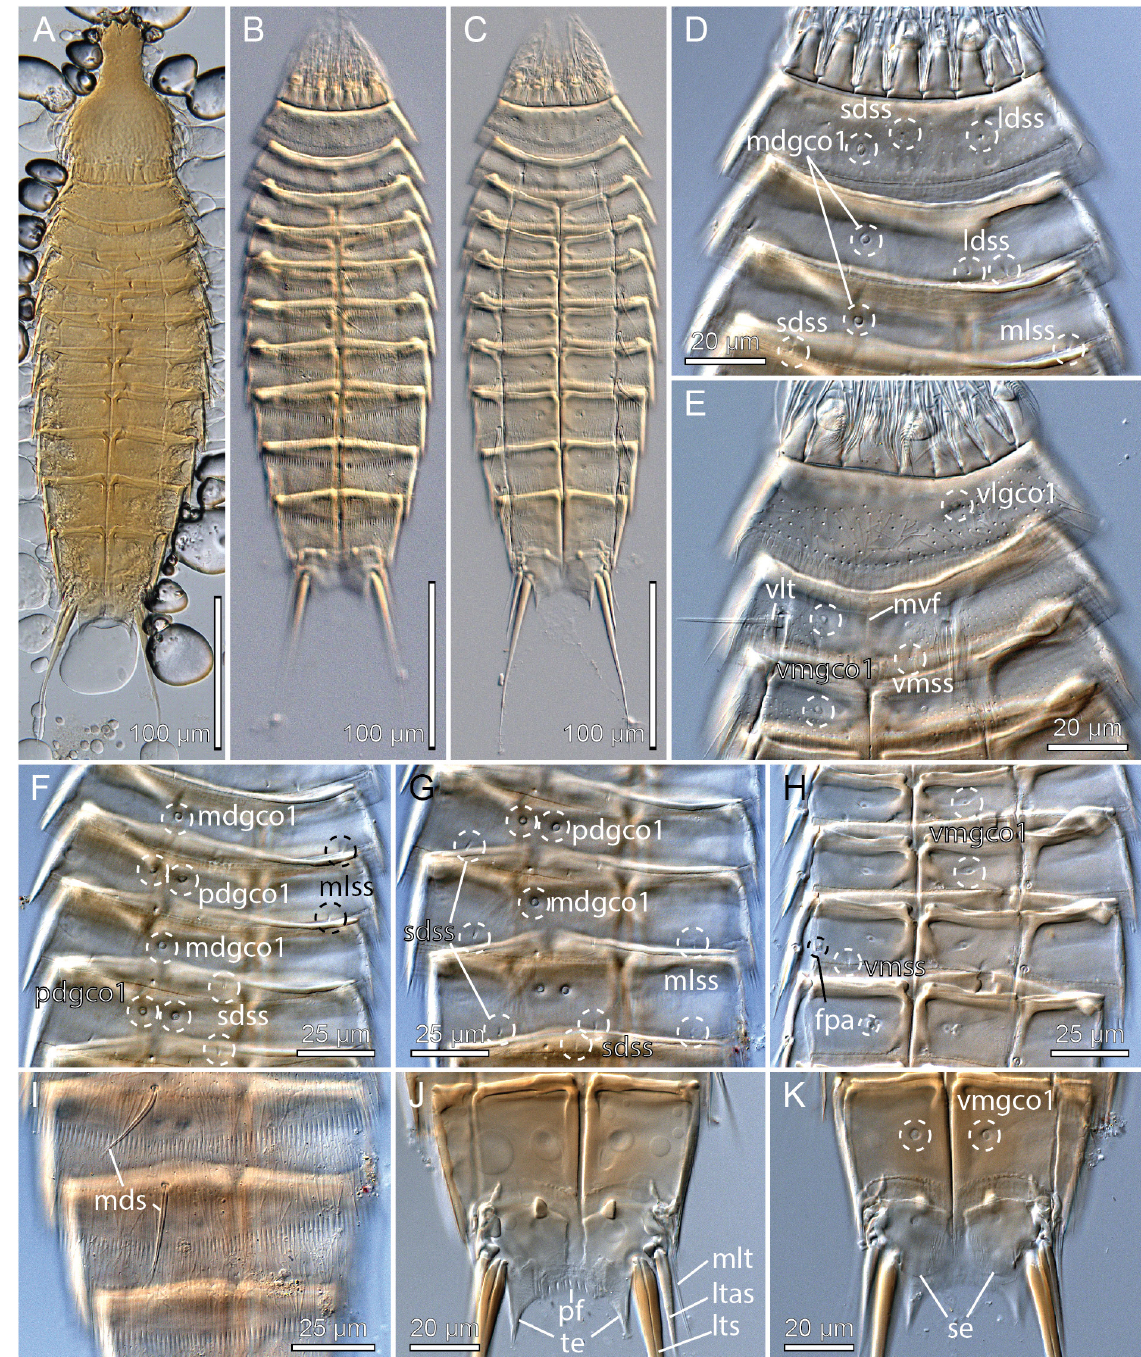
Fig. 1. Light micrographs showing overviews and details of Echinoderes aureus Adrianov et al ., 2002 . A . Allotype, ♀ (SMBL-397). B–C . Non-type ♀ from Tanegashima (NHMD-664220). D–K . Topotype, ♀ (ICHUM-6124 ). A . Ventral overview. B . Dorsal overview. C . Ventral overview. D . Segments 1 to 3, dorsal view. E . Segments 1 to 3, ventral view. F . Segments 3 to 6, dorsal view. G . Segments 6 to 8, dorsal view. H . Segments 6 to 8, ventral view, showing female sexual dimorphism. I . Segments 7 to 9, dorsal view. J . Segments 10 to 11, focused on posterior margin of tergal plate of segment 11, showing female sexual dimorphism. K . Segments 10 to 11, ventral view, showing female sexual